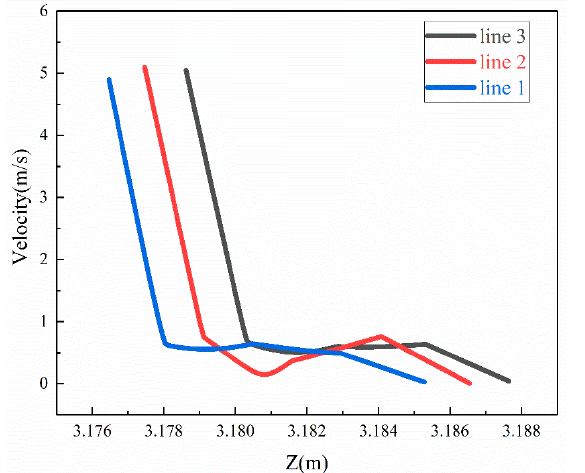
Figure 16. Gas vortex in the holes.